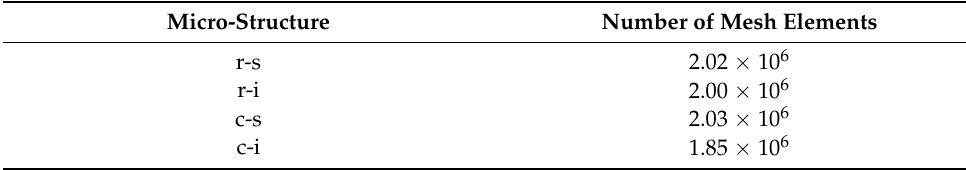
Table 1. Meshing of different micro